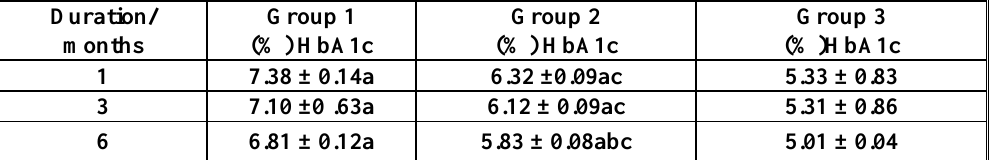
Table 3 : Effect of treatment with metformin 500 mg 3 times daily + glibenclamide 5 mg twice daily( group 1) versus group 2 metformin 500 mg 3 times daily + sitagliptin 100 mg once daily (group 2) on HbA1c in patients with T2DM and control normal healthy individuals group (3)